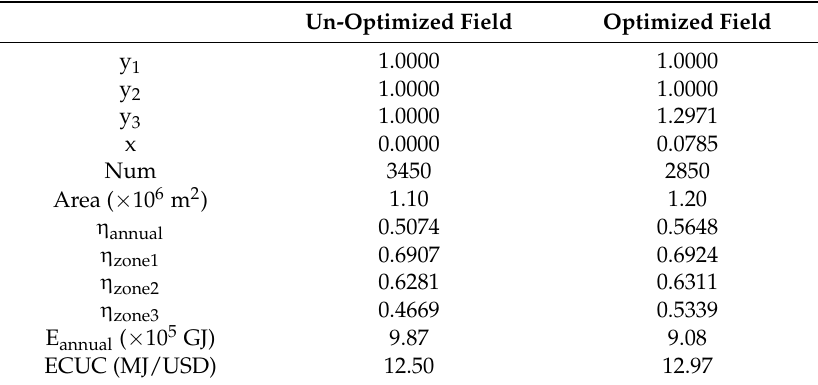
Table 4. Optimization results of the heliostat field on annual basis using PSO-GA